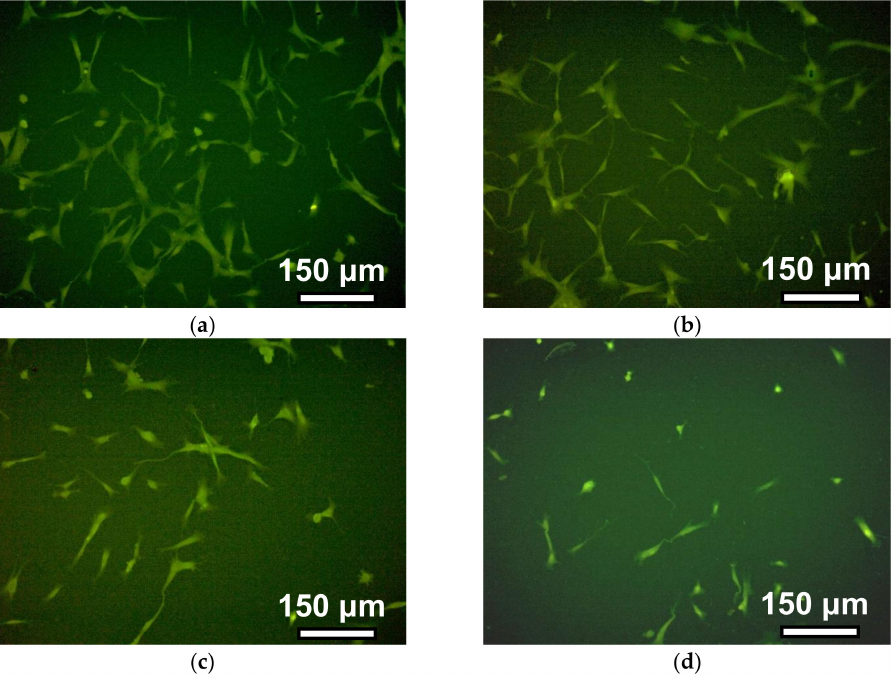
Figure 7. Human dermal fibroblasts on PAAm gels with different crosslinking densities after 4 days of incubation. Magnification × 100, staining of the cytoplasm of cells with pyrazolone yellow. Photos correspond to gels with a crosslinking density of 1:50 ( a ), 1:100 ( b ), 1:200 ( c ), and 1:300 ( d